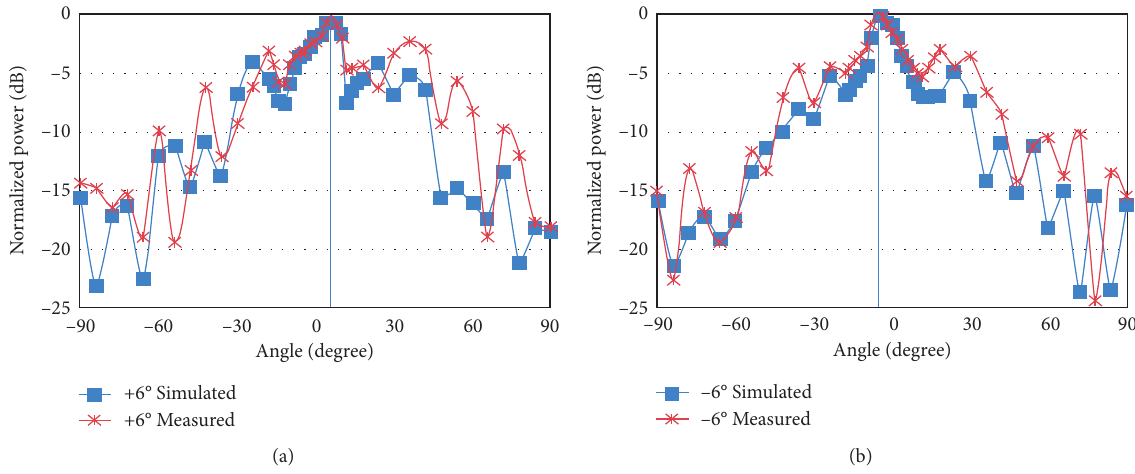
Figure 7: Measured and simulated radiation patterns of reflectarrays. (a) +6 ° switched beam. (b) − 6 ° switched beam at